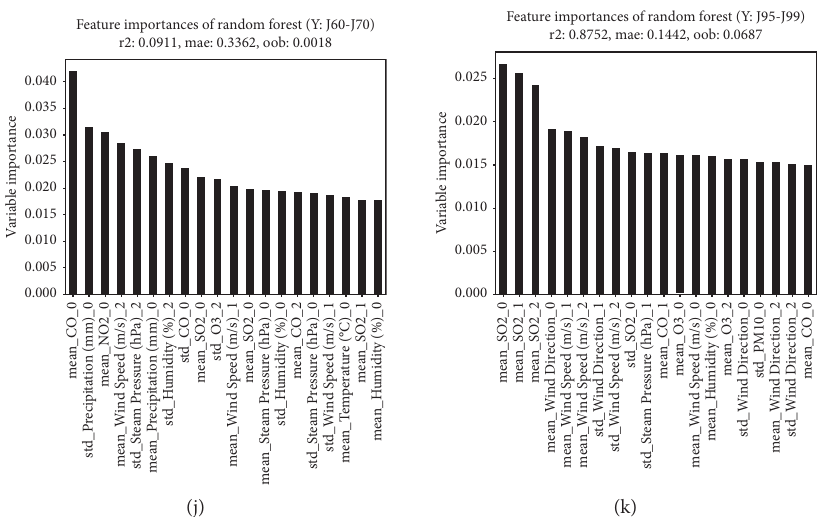
Figure 4: Analysis of the correlation between respiratory disease patients’ visit to the ED and air pollution and weather variables (day 0–2). (a) [J00-J06] Acute upper respiratory infections. (b) [J09-J11] Influenza. (c) [J12-J18] Pneumonia. (d) [J20-J22] Other acute lower re- spiratory infections. (e) [J30-J39] Other diseases of upper respiratory tract. (f) [J40-J47] Chronic lower respiratory diseases. (g) [J60-J70] Lung diseases due to external agents. (h) [J80-J84] Other respiratory diseases principally affecting the interstitium. (i) [J85-J86] Suppurative and necrotic conditions of lower respiratory tract. (j) [J90-J94] Other diseases of pleura. (k) [J95-J99] Other diseases of the respiratory